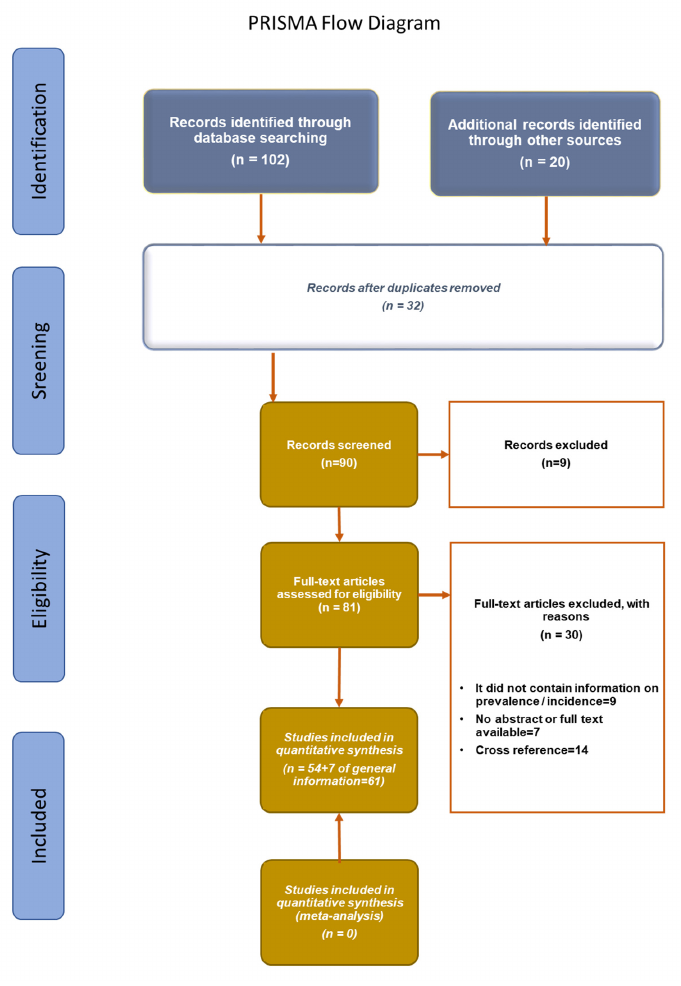
Figure 1. Flowchart of the different phases of the systematic review.